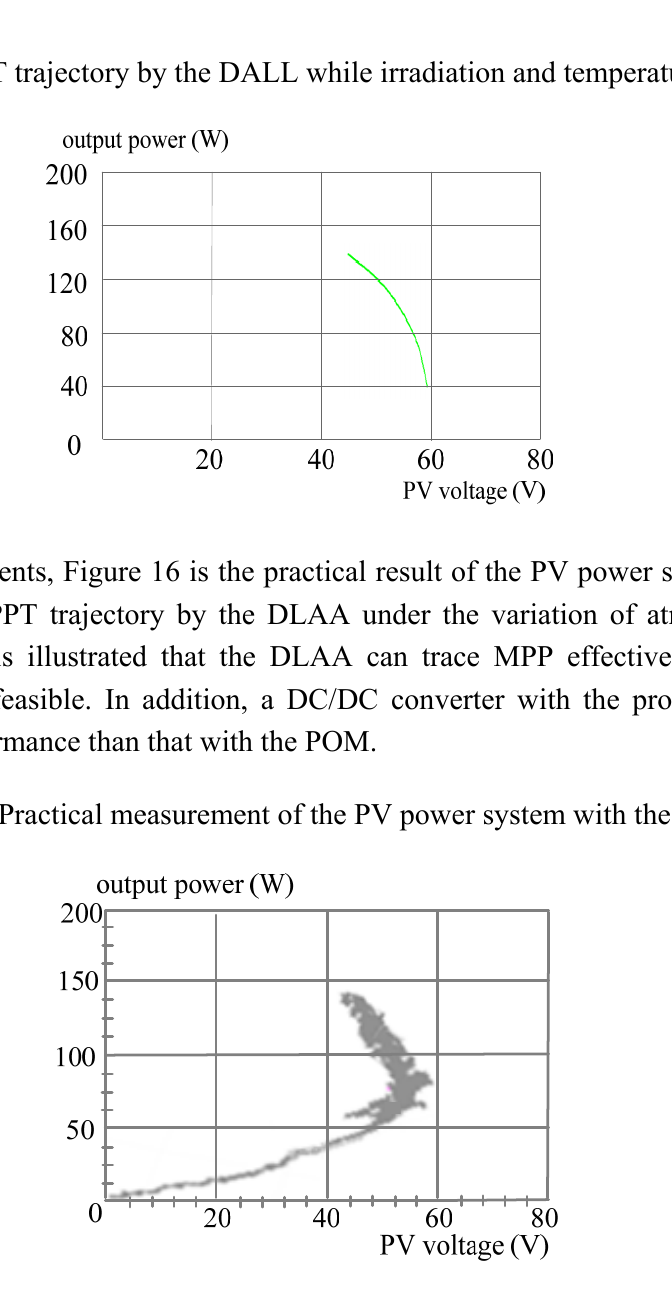
Figure 17. Practical measurement of the PV power system with the